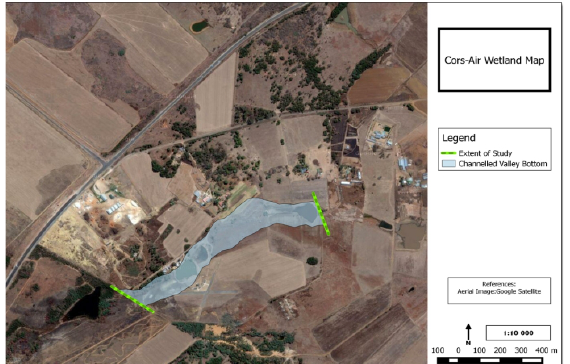
Figure 1. The Cors-Air channelled valley-bottom wetland.